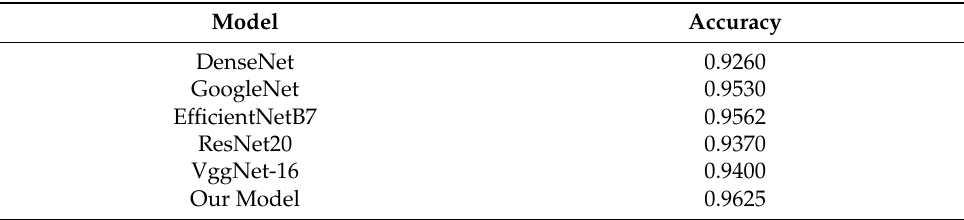
Table 5. Comparison of previous models with our model.